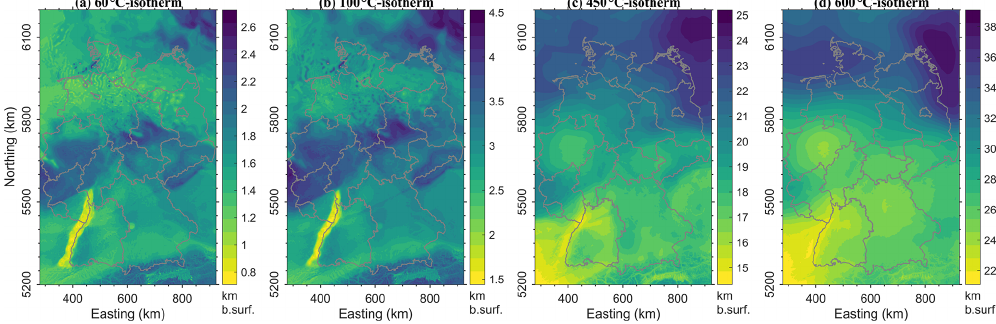
( < 6 . 5 km s − 1 ) and densities ( < 2850 kg m − 3 ) and